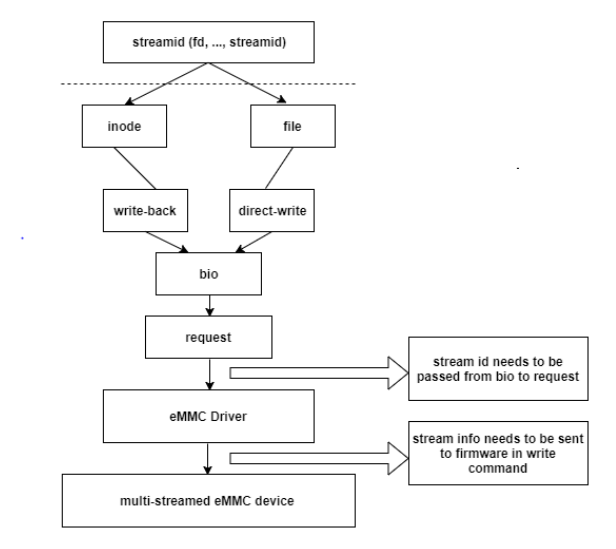
Figure 2. Application is passing stream id for eMMC, through system